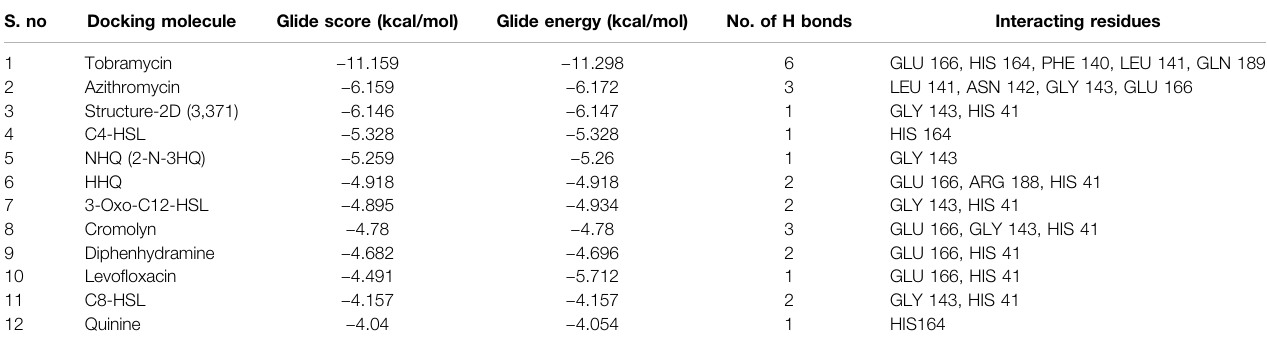
TABLE 1 | Molecular interaction characterization showing the docking score of T2Rs agonist onto the COVID-19 virus spike protein structure. S. no Docking molecule Glide score (kcal/mol) Glide energy (kcal/mol) No. of H bonds Interacting